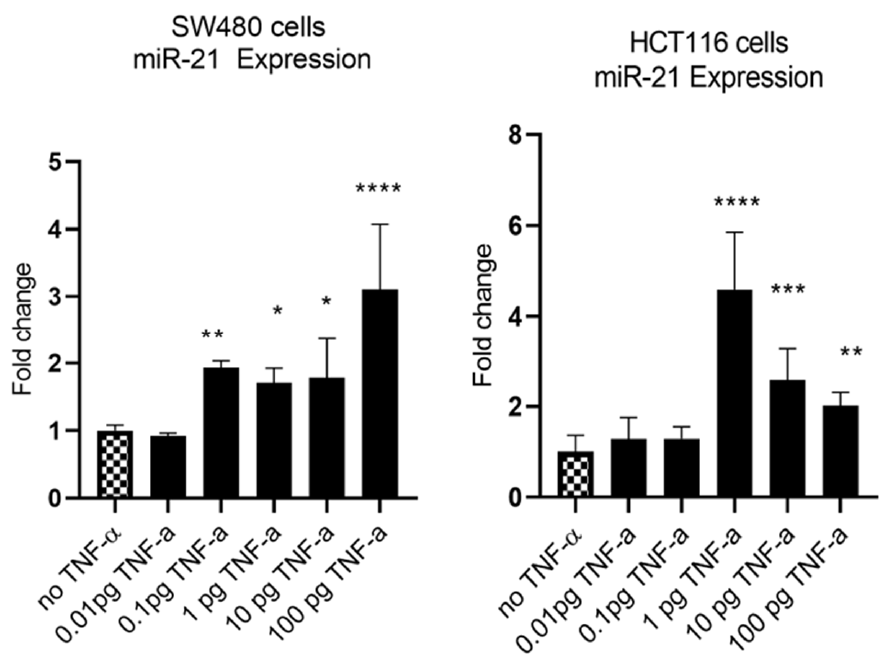
Figure 2. TNF- α effects on miR-21 expression. SW480 and HCT116 cells were treated with 0 to Figure 2. TNF ‐α effects on miR ‐ 21 expression. SW480 and HCT116 cells were treated with 0 to 100 100 pg/mL of TNF- α for 24 h. MiR-21 expression was measured by RT-qPCR. Data were normalised pg/mL of TNF ‐α for 24 h. MiR ‐ 21 expression was measured by RT ‐ qPCR. Data were normalised to to expression of U6 RNA and are shown relative to vehicle control (no TNF- α ). Significant difference expression of U6 RNA and are shown relative to vehicle control (no TNF ‐α ). Significant difference was calculated using one-way ANOVA with Dunnett’s test (GraphPad Prism 8, * p < 0.05, ** p < 0.01, *** p < 0.001, **** p < 0.0001). Data are presented as fold changes of three biological replicates relative to control. Error bars represent the SEM for independent to control. Error bars represent the SEM for independent cultures.